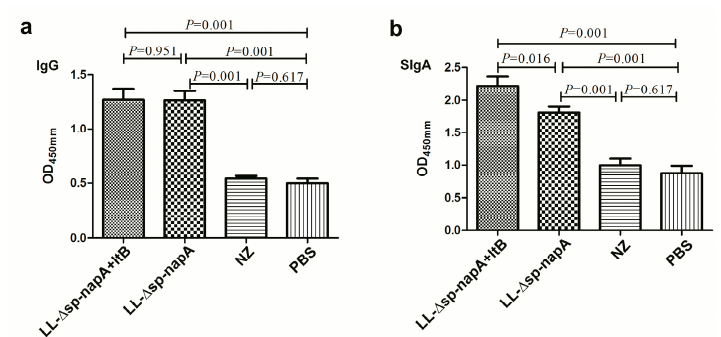
Figure 3. Evaluation of anti-NapA IgG and SIgA levels of the mice. ( a ) ELISA results of serum anti-NapA IgG antibody. ( b ) ELISA data of fecal NapA-specific SIgA antibody. The NZ- ∆ sp-napA , NZ- ∆ sp-napA + ltB , NZ and PBS groups (n = 11 each) were orally gavaged with bacterial suspension of NZ3900 / pNZ- ∆ sp- napA , mixture of NZ3900 / pNZ- ∆ sp- napA and NZ3900 / pNZ-sp- ltB , NZ3900 / pNZ8110, PBS, respectively. The sera and feces of mice were sampled from the mice one week after the immunization, diluted at 1:50 and tested for anti-NapA immunoglobulins. ELISA tests were replicated for three times. Data were shown as mean ± SEM. Error bars indicate standard deviations.